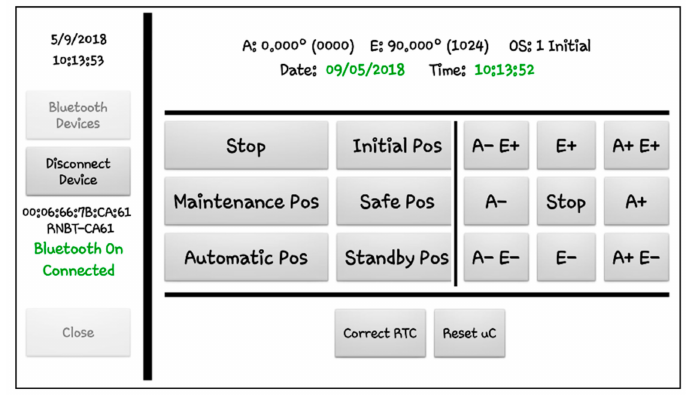
Figure 21. Mobile App.